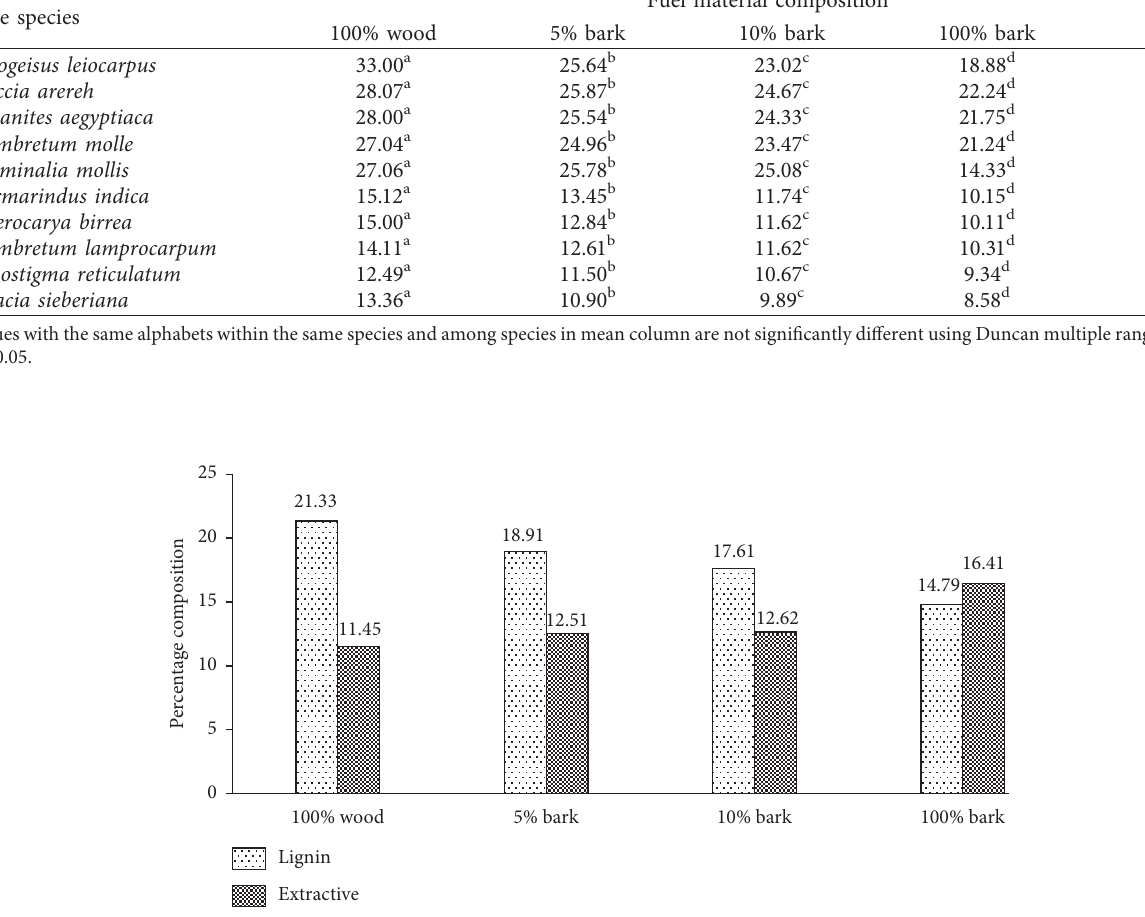
Figure 2: Average lignin and extractive content (%) of the fuel materials from the selected fuelwood